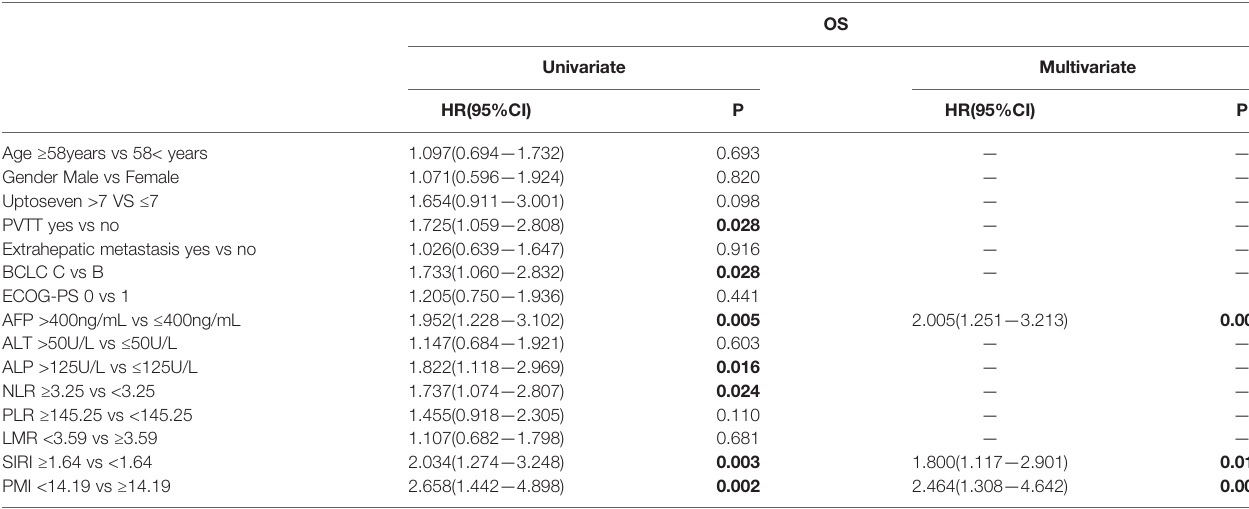
TABLE 4 | Prognostic factors for overall survival.